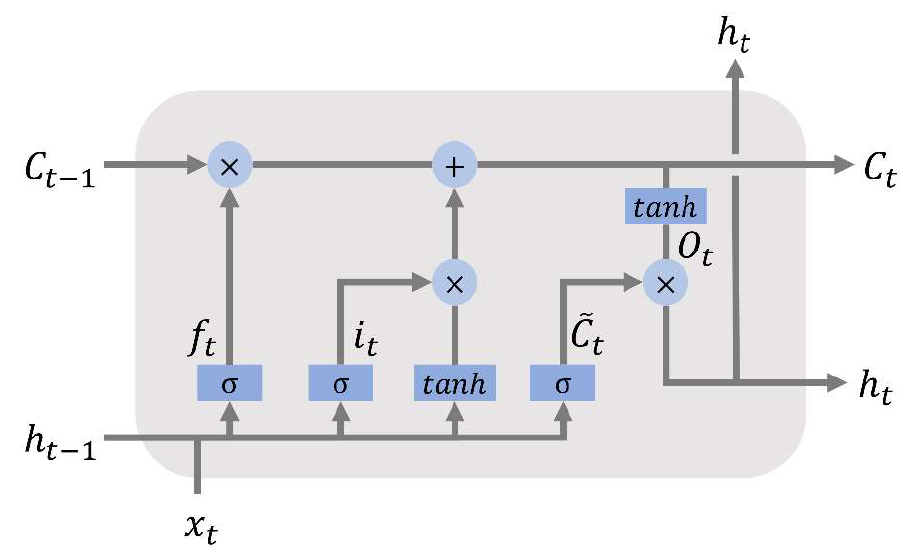
Figure 5. The internal structure of LSTM.